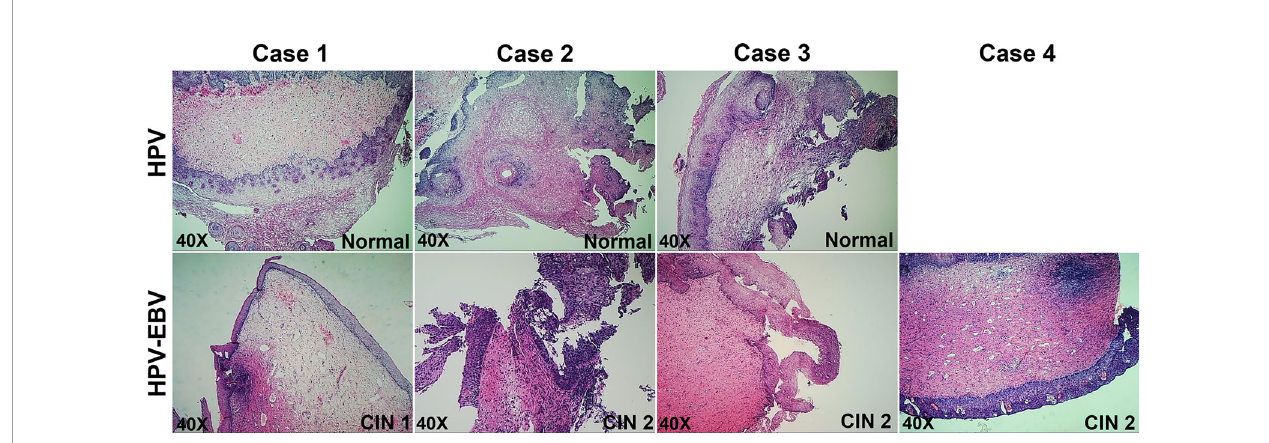
FIGURE 2 | Pathology of cervical tissues involved in mRNA-seq.